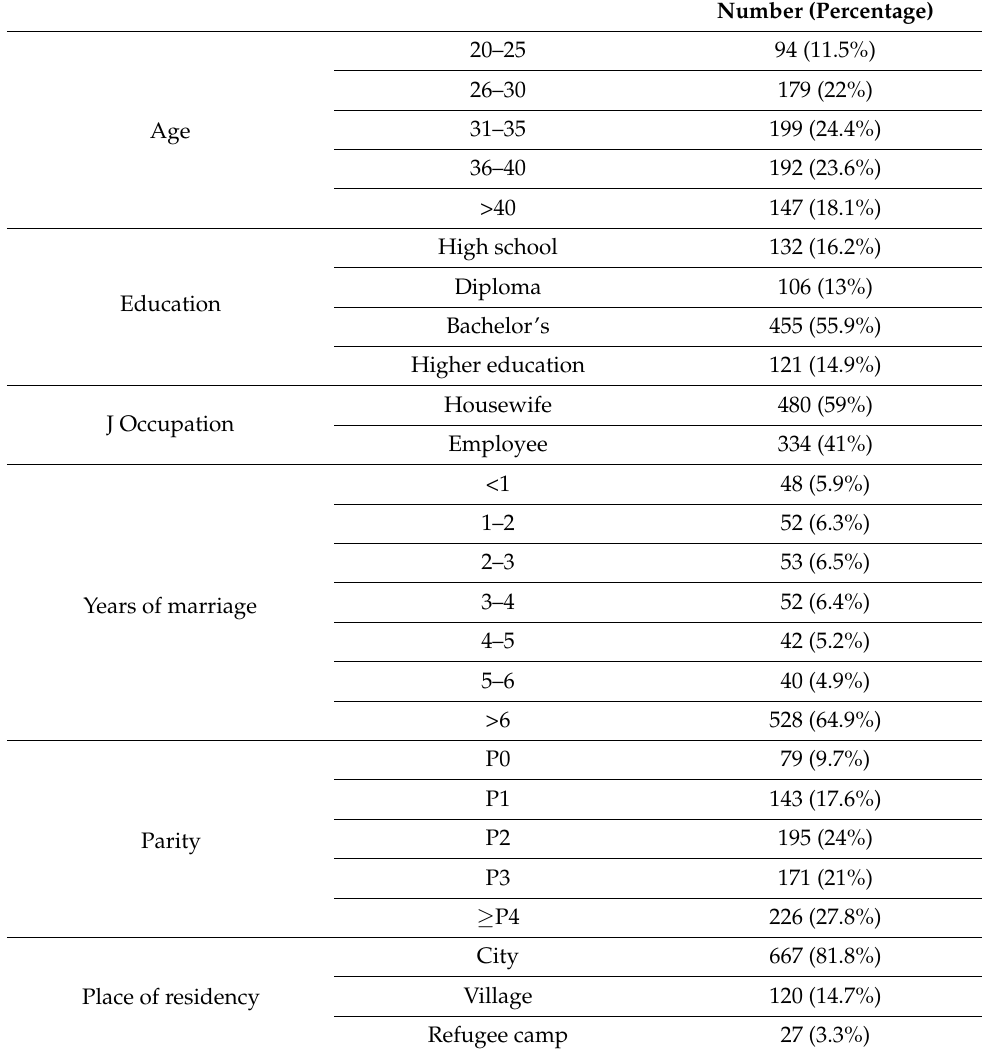
Table 1. General characteristics of the participating women (n =